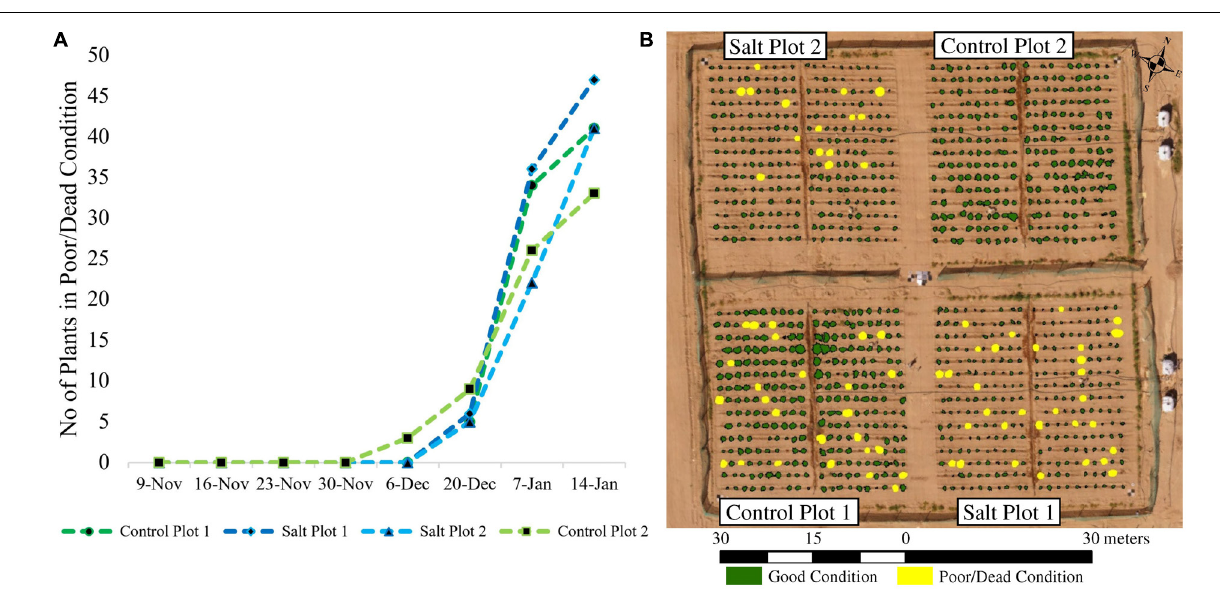
FIGURE 7 | (A) Cumulative number of plants either missing or being in a poor/dead condition throughout the growing season; and (B) mapped plants in either good or poor/dead condition on January 7, 2018. Missing plants were either blown away during the sandstorms or removed if they were dead to allow their yield to be assessed prior to harvesting the plots. At the time of flight on January 7, all dead plants had been removed in control plot